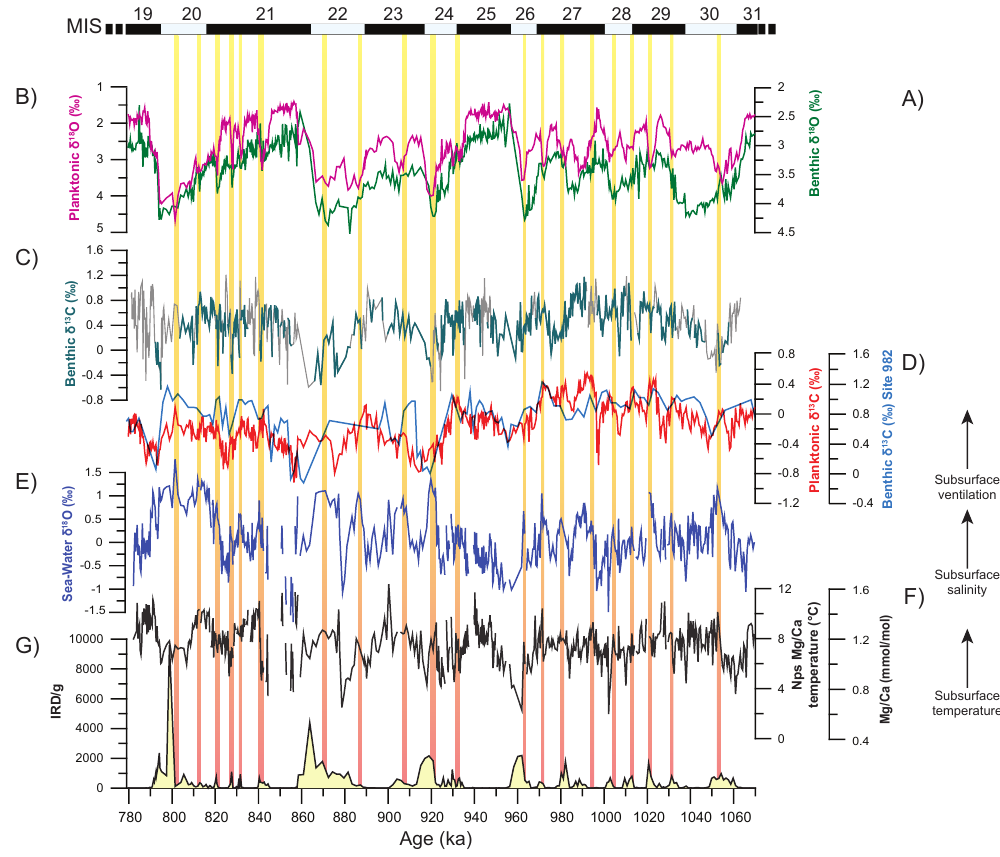
Figure 2. Data for IODP Site U1314 spanning MIS 31–19 vs. age. From top to bottom: (a) benthic (Hernández-Almeida et al., 2013a) and (b) planktonic δ 18 O (Hernández-Almeida et al., 2012); (c) benthic δ 13 C (Hernández-Almeida et al., 2013a) ( Cibicidoides spp., green; adjusted M. pompilioides, grey); (d) planktonic δ 13 C (red) (Hernández-Almeida et al., 2013b) vs. benthic δ 13 C from Site 982 (blue) (Venz et al., 1999); (e) δ 18 O sw reconstruction from paired Mg / Ca and δ 18 O measurements of the planktonic foraminifera Neogloboquadrina pachyderma (sin.); (f) Mg / Ca-derived palaeotemperature calculated using exponential temperature equation of Elderfield and Ganssen (2000). (g) IRD/g (Hernández-Almeida et al., 2012). Vertical bars indicate maxima of the δ 18 O sw associated with each subsurface heat and salt